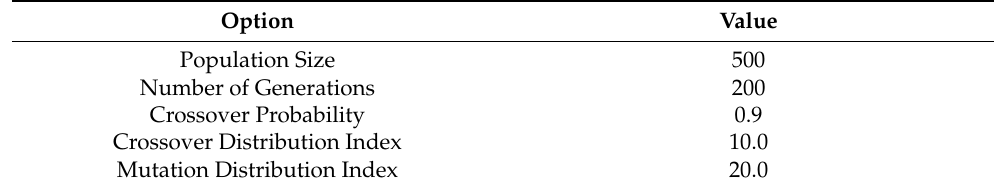
Table 8. NSGA-II algorithm setup.